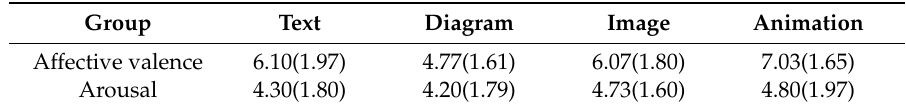
Table 7. Means and standard deviations for affective valence and arousal (standard deviation in parentheses; unit: points; nine-point Likert